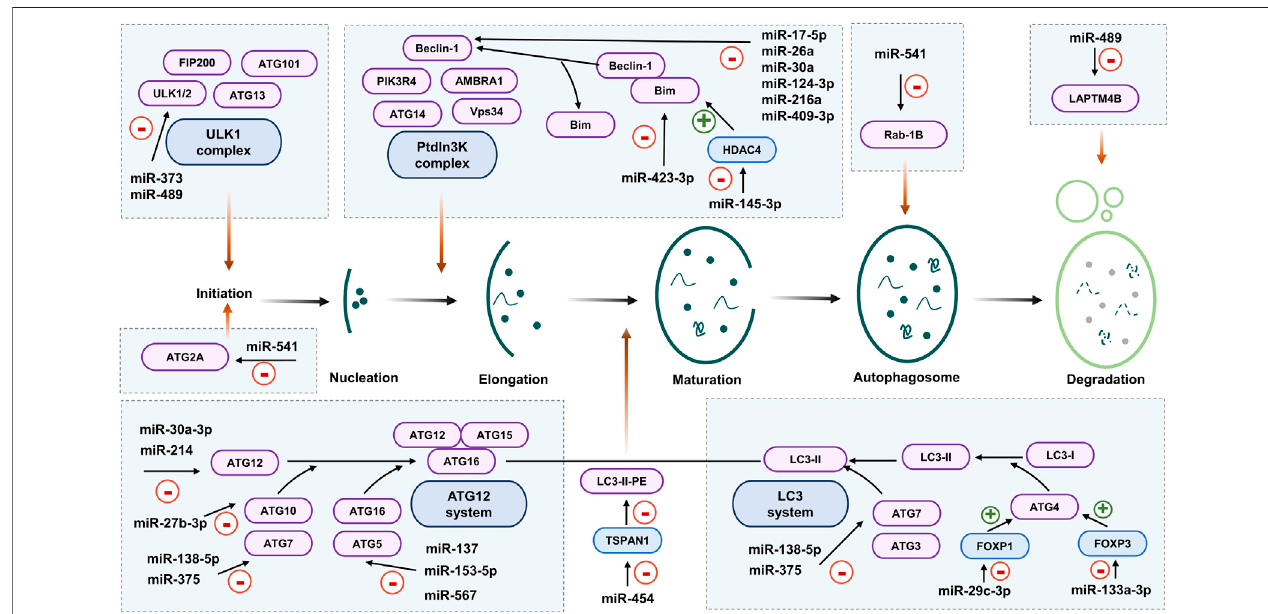
FIGURE2| miRNAregulationofautophagiccomponents.Duringautophagyinitiation,theUnc-51likeautophagyactivatingkinase(ULK)complexactivitycouldbe diminished bymiR-489or miR-373, which targetULK1. Also, ATG2A could be negatively regulated by miR-541. Beclin-1 istargeted bymiR-17-5p, miR-26a, miR-30a, miR-124-3p, miR-216a, and miR-409-3p. Beclin-1 activity is controlled by its interaction with Bim. In this sense, miR-423-3p increases autophagy activity by targeting Bim and miR-145-5p activates autophagy by downregulating histone deacetylase 4 (HDAC4), which controls Bim expression. The ATG12 conjugation system is tightly regulated by miRNAs. ATG12 is negatively regulated by miR-30a-3p and miR-214; ATG10 is targeted by miR-27b-3p; ATG7 is controlled by miR-138-5p and miR-375; and ATG5 expression is regulated by miR-137, miR-153-5p and miR-567. Lipidation of LC3 is potentiated by miR-454, that targets tetraspanin 1 (TSPAN1) and increases its turnover. ATG4 expression is negatively regulated by miR-29c-3p and miR-133a-3p through Forkhead box gene P1 (FOXP1) and Forkhead box gene P3(FOXP3),respectively.Laterstagesofautophagyarelessregulated.miR-541participatesinautophagosomecompetitionbymeansofRab-1B.miR-489participates in degradation through targeting lysosomal protein transmembrane 4 beta